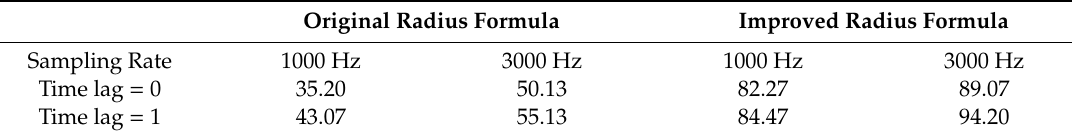
Table 5. Comparison of di ff erent sampling frequency and time-delay coe ffi cients.